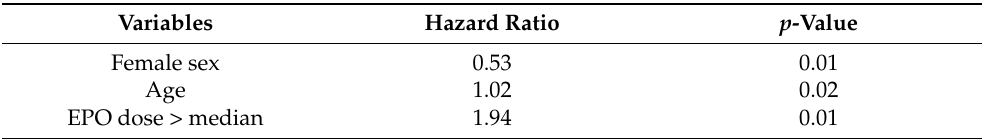
Table 5. Factors associated with the overall mortality over the long term (78 months): multivariate Cox regression